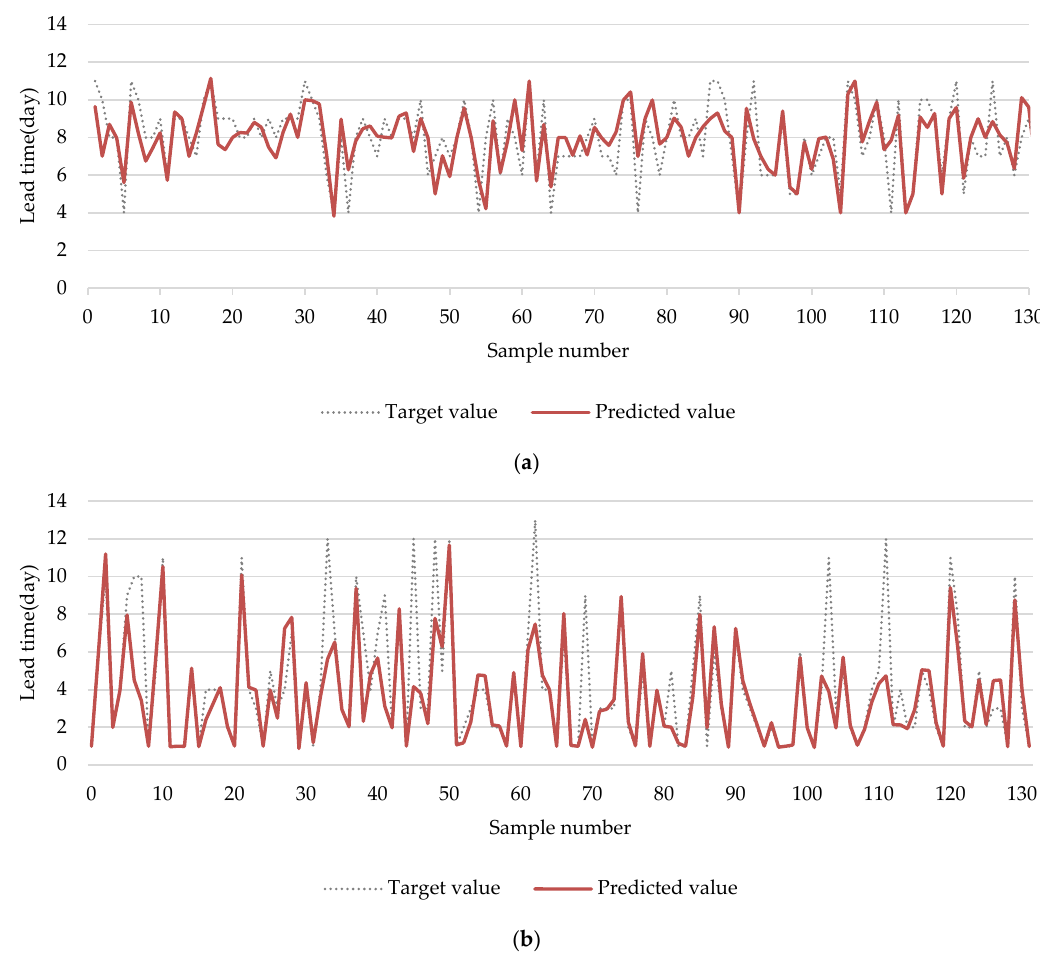
Figure 9. NHPSO-JTVAC-SVM model’s predicted results of the ( a ) block assembly process performance test set and ( b ) block pre-outfitting process performance test set.